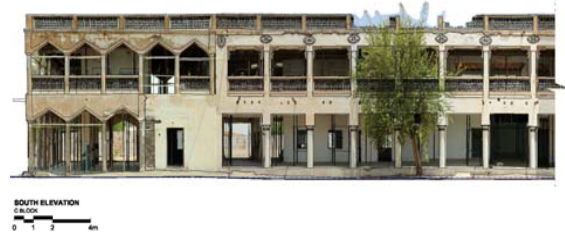
Figure 6. A rectified south elevation of private block.